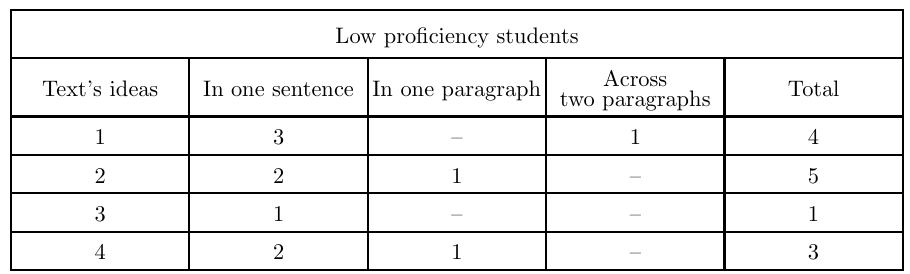
Used ideas (low proficiency